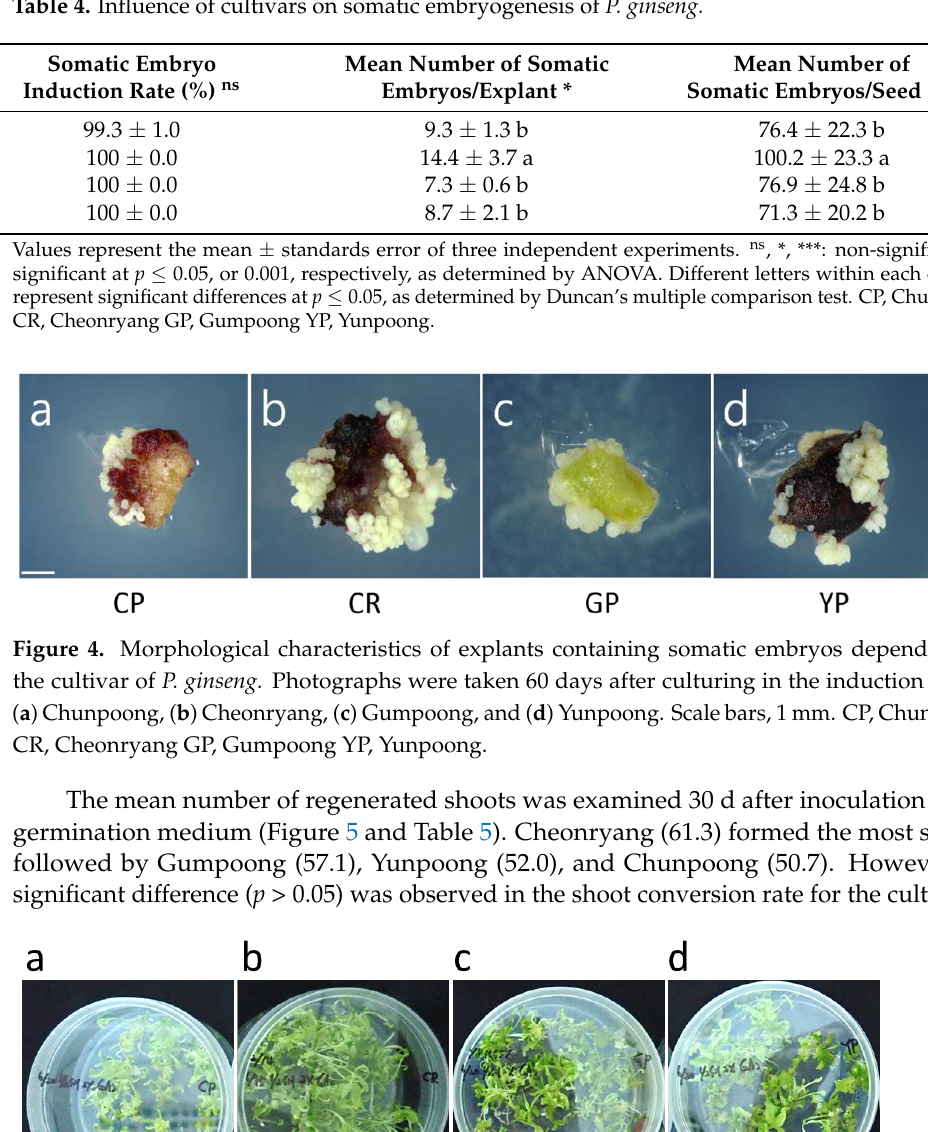
Figure 3. Morphological characteristics of dehiscent seeds depending on the cultivar of P. ginseng . After the stratification treatment for 90 days, the dehiscent seeds removed the seed coat. The seeds were evaluated for main characteristics, including weight, length, and diameter. ( a ) Chunpoong, ( b ) Cheonryang, ( c ) Gumpoong, and ( d ) Yunpoong. Scale bars, 1 mm. CP, Chunpoong; CR, Cheon- ryang; GP, Gumpoong; YP, Yunpoong.